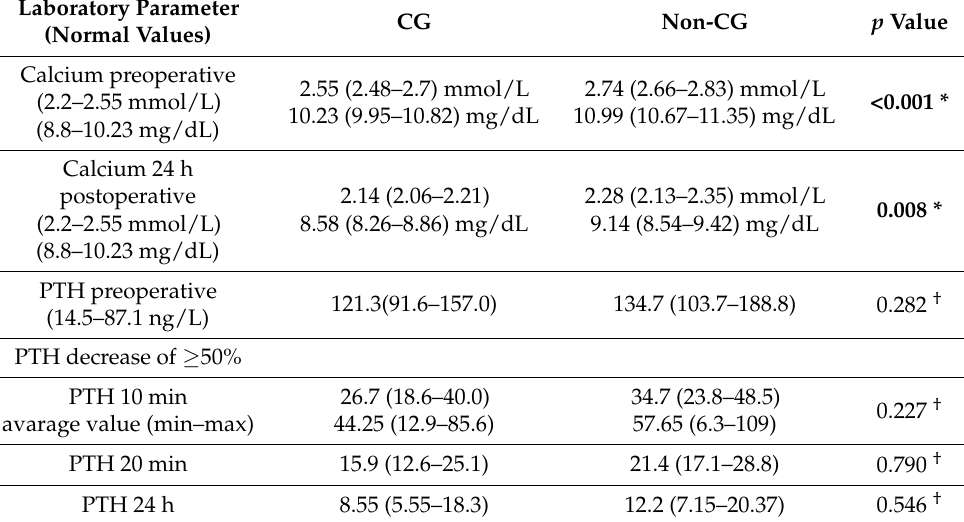
Table 2. Perioperative biochemical changes.